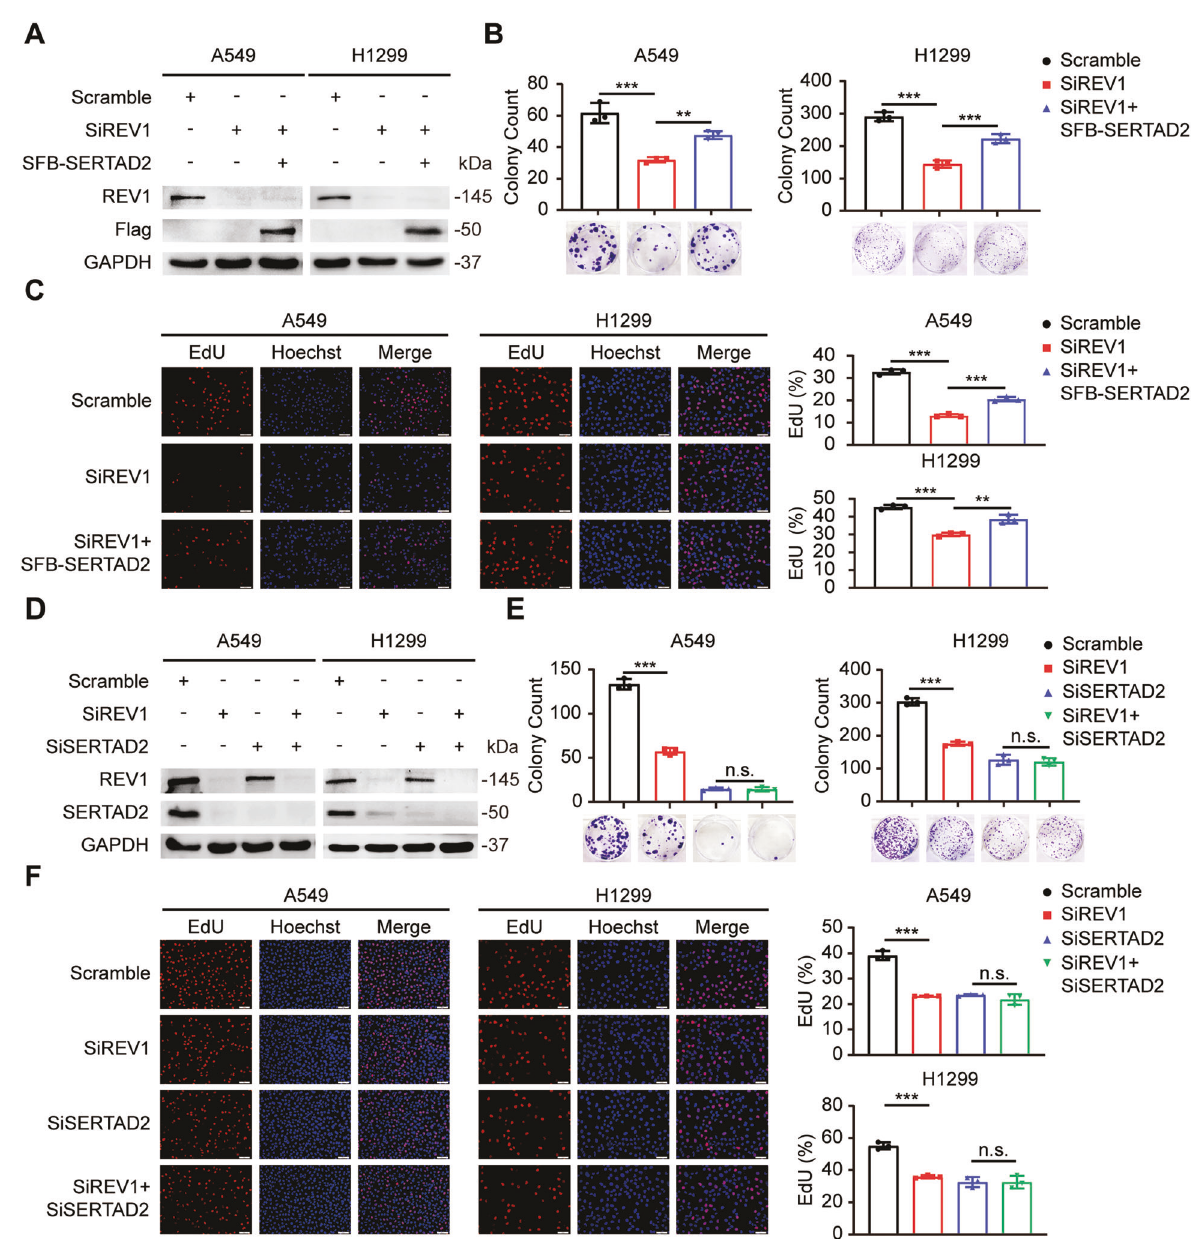
Fig. 5 The inhibitory effect of REV1 silencing on the proliferation of lung cancer cells is partially dependent on SERTAD2. A A549 and H1299 cells transfected with the indicated siRNAs and SFB-SERTAD2 were harvested and analyzed by Western blot ( n = 3). B Cells transfected with the indicated siRNAs and SFB-SERTAD2 were seeded in a six-well plate in triplicate and grown for two weeks. Representative pictures of colony formation in each group and quantitative analysis of the colony counts are shown. ** P < 0.01, *** P < 0.001 ( n = 3). C EdU incorporation assays were used to test the proliferation of cells transfected with the indicated siRNAs and SFB-SERTAD2. ** P < 0.01, *** P < 0.001 ( n = 3). Scale bar: 50 μ m. D A549 and H1299 cells transfected with the indicated siRNAs were harvested and analyzed by Western blot ( n = 3). E Colony formation assays were conducted to examine the proliferation ability of cells transfected with the indicated siRNAs. *** P < 0.001, n.s. P > 0.05 ( n = 3). F Representative fl uorescence images of each group transfected with the indicated siRNAs from EdU incorporation assays and statistical analysis results are presented. *** P < 0.001, n.s. P > 0.05 ( n = 3). Scale bar: 50 μ